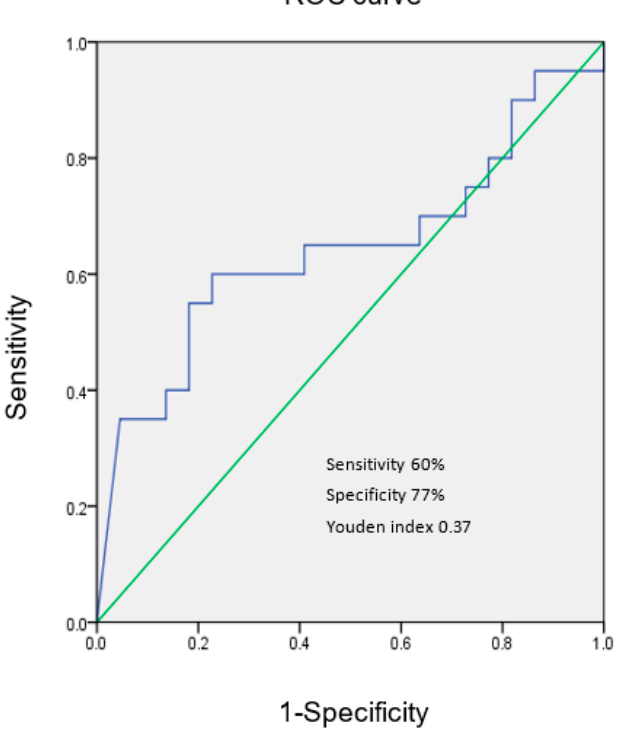
Figure 4. ROC curve for differentiating KD patients with/without acute CALs in the post-IVIG acute phase at the cut-off value of VEGF 1106.7 pg/mL .